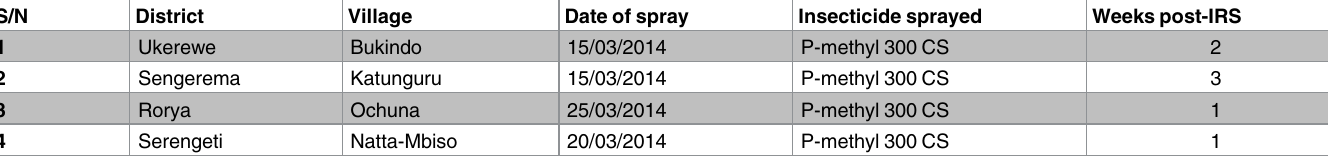
Table 1. Spraying schedule in districts and timing of first monitoring visit post